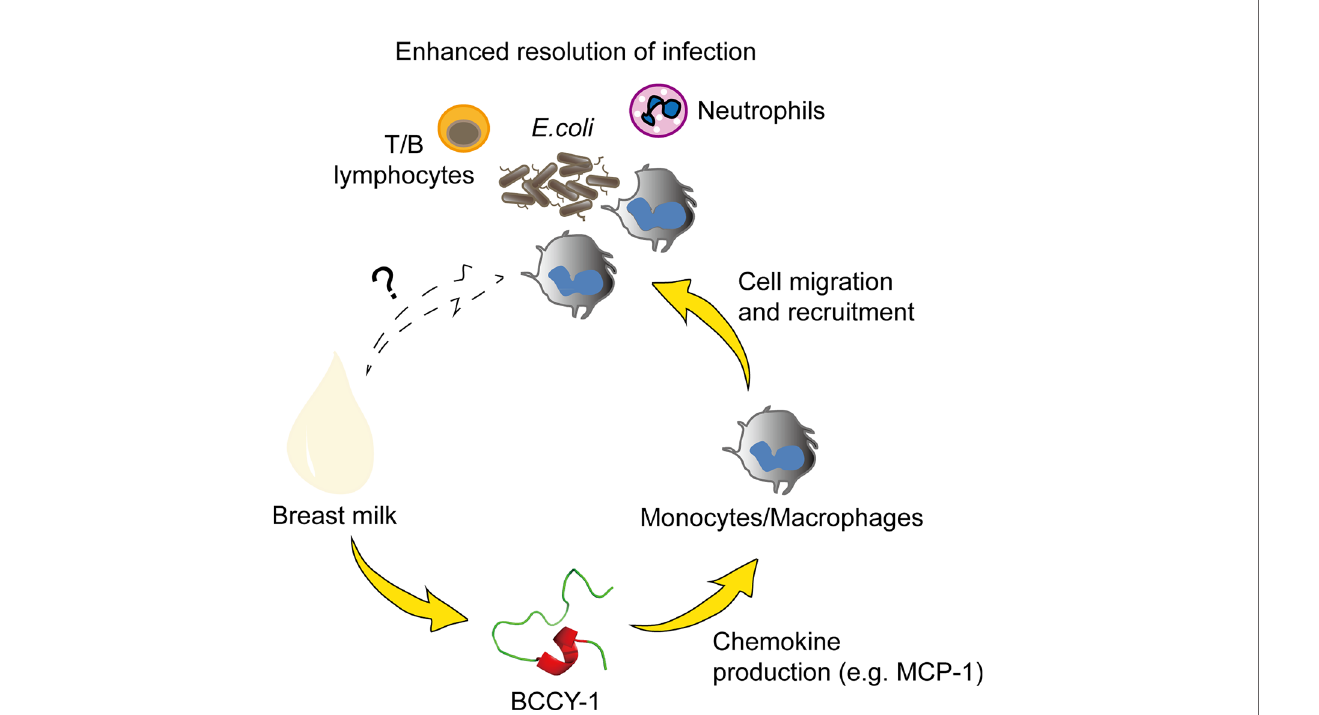
FIGURE 7 | Proposed anti-infective action of peptide BCCY-1. Monocytes/macrophages, T/B lymphocytes and neutrophils are all involved in the host defense against bacterial infection. The human b -casein-derived peptide BCCY-1 enhances the production of chemokines, such as MCP-1. As a result, monocytes/ macrophages are recruited to the infection site and assist in resolving bacterial infections (e.g. E.coli